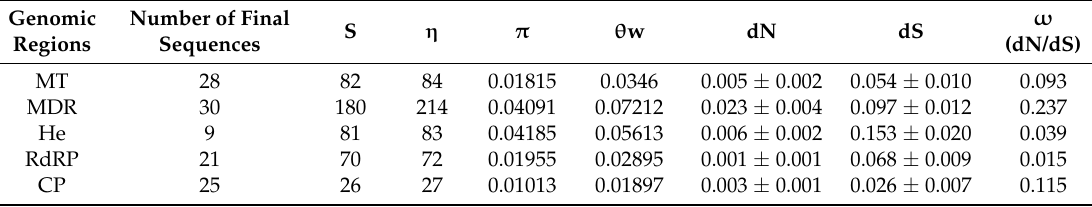
Table 4. Population genetic parameters estimated for five coding regions of CSDaV isolates using the DnaSP and MEGA